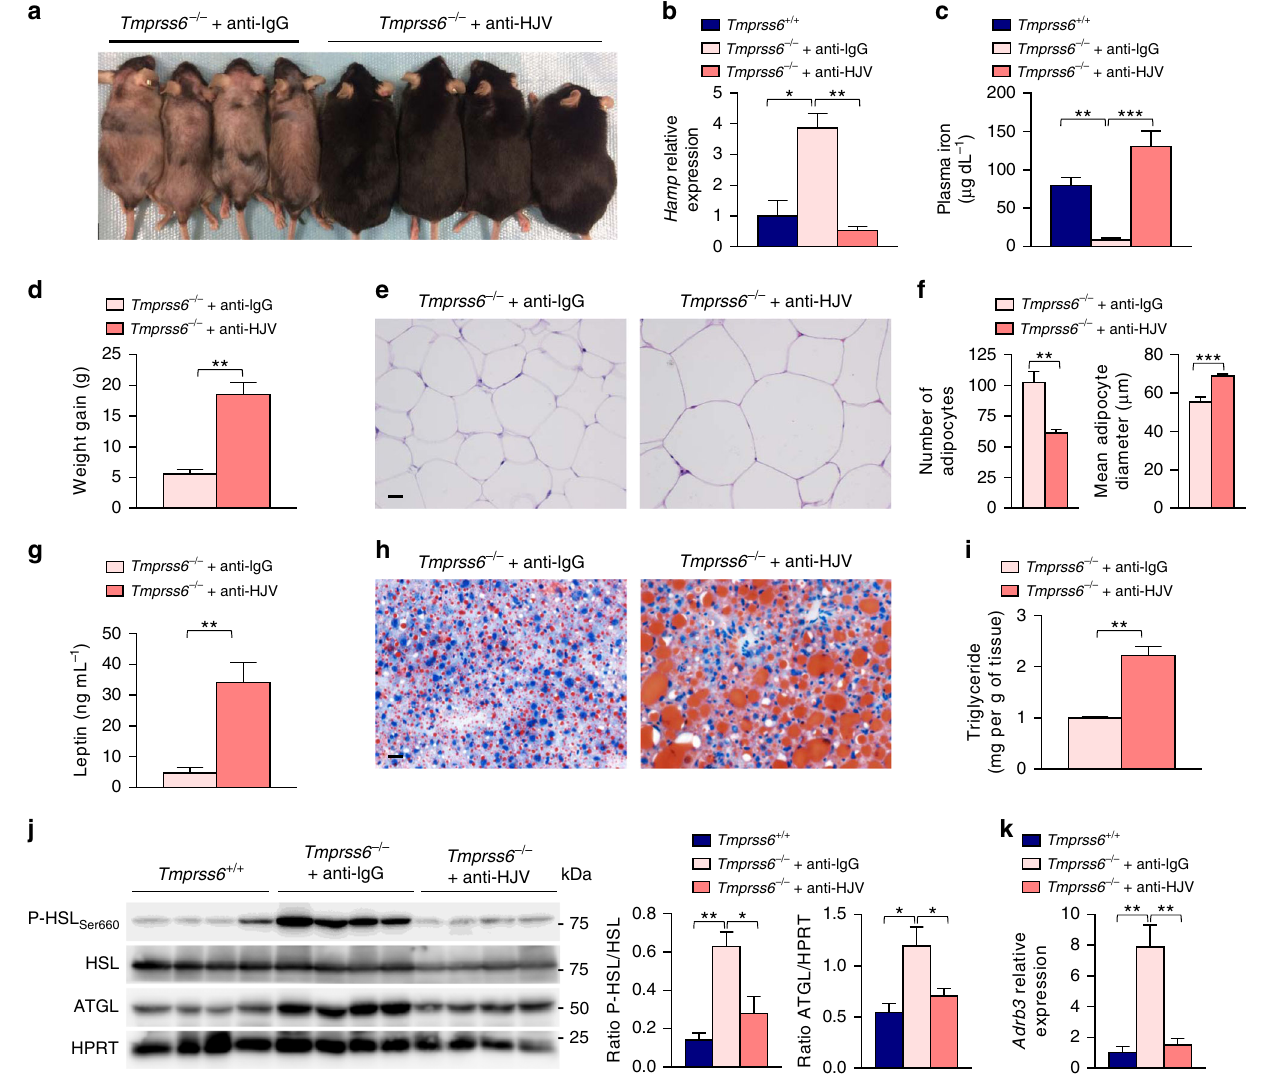
Fig. 6 Hepcidin down-regulation in Tmprss6 -de fi cient mice reverts the obesity-resistant phenotype. a Representative image of HFD-fed Tmprss6 − / − mice treated weekly with anti-HJV neutralizing antibody or control anti-IgG for 18 weeks. The image shows the hair coat recovery and the increased body weight of anti-HJV-treated Tmprss6 − / − mice compared to Tmprss6 − / − mice treated with control anti-IgG. b Relative gene expression of hepcidin ( Hamp ) in liver samples from HFD-fed Tmprss6 + / + ( n = 7), anti-IgG-treated Tmprss6 − / − ( n = 5), and anti-HJV-treated Tmprss6 − / − ( n = 8) mice. c Fasting plasma concentration of iron in HFD-fed Tmprss6 + / + ( n = 4), anti-IgG-treated Tmprss6 − / − ( n = 5), and anti-HJV-treated Tmprss6 − / − ( n = 8) mice. d Weight gain of anti-IgG-treated Tmprss6 − / − ( n = 5), and anti-HJV-treated Tmprss6 − / − ( n = 8) HFD-fed mice after 18 weeks of antibody administration. e Representative images of epididymal fat pad sections stained with H&E from HFD-fed anti-IgG-treated Tmprss6 − / − ( n = 5) and anti-HJV-treated Tmprss6 − / − ( n = 8) mice. f Number and size of epididymal adipocytes in HFD-fed anti-IgG-treated Tmprss6 − / − ( n = 5), and anti-HJV-treated Tmprss6 − / − ( n = 8) mice. g Fasting plasma concentration of leptin in anti-IgG-treated Tmprss6 − / − ( n = 5), and anti-HJV-treated Tmprss6 − / − ( n = 8) mice fed a HFD. h Representative Oil Red O staining of liver sections from anti-IgG-treated Tmprss6 − / − ( n = 5), and anti-HJV-treated Tmprss6 − / − ( n = 8) mice fed a HFD. i Triglyceride content of liver samples from HFD-fed anti-IgG-treated Tmprss6 − / − ( n = 5), and anti-HJV-treated Tmprss6 − / − ( n = 8) mice. j Western-blot analysis of phospho-HSL(Ser660), total HSL and ATGL protein expression in WAT samples from HFD-fed Tmprss6 + / + ( n = 5), anti-IgG-treated Tmprss6 − / − ( n = 5), and anti-HJV-treated Tmprss6 − / − ( n = 8) mice. (left) A representative result showing decreased phospho-HSL and ATGL protein levels in anti- HJV-treated Tmprss6 − / − mice compared to anti-IgG-treated Tmprss6 − / − mice. (right) Quanti fi cation of phospho-HSL protein levels relative to total HSL levels and ATGL protein levels relative to loading control HPRT. Note that phospho-HSL and the corresponding loading control, the total HSL protein, were detected on the same samples run in parallel in two identical blots. k Relative gene expression of Adrb3 in WAT samples from HFD-fed Tmprss6 + / + ( n = 8), anti-IgG-treated Tmprss6 − / − ( n = 5), and anti-HJV-treated Tmprss6 − / − ( n = 8) mice. Scale bar 20 µ m. Data shown are mean ± SEM. * P <